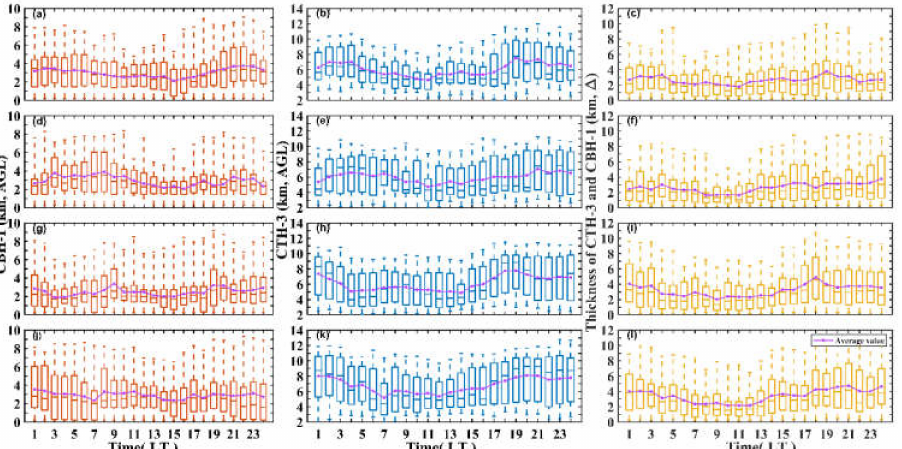
Figure 10. Diurnal variations of base height of the lowest-layer clouds (CBH-1), top height of the highest-layer clouds (CTH-3), and the thickness of CTH-3 and CBH-1 at four sites. In box and whisker plots, the upper and lower lines of each box represent the 75% and 25% values, respectively, and the red/blue/yellow solid line inside the box indicates the median position. ( a , d , g , j ) CBH-1; ( b , e , h , k ) CTH-3; ( c , f , i , l ) thickness of CTH-3 and CBH-1. ( a – c ) GZ; ( d – f ) LT; ( g – i ) DC; ( j – l )